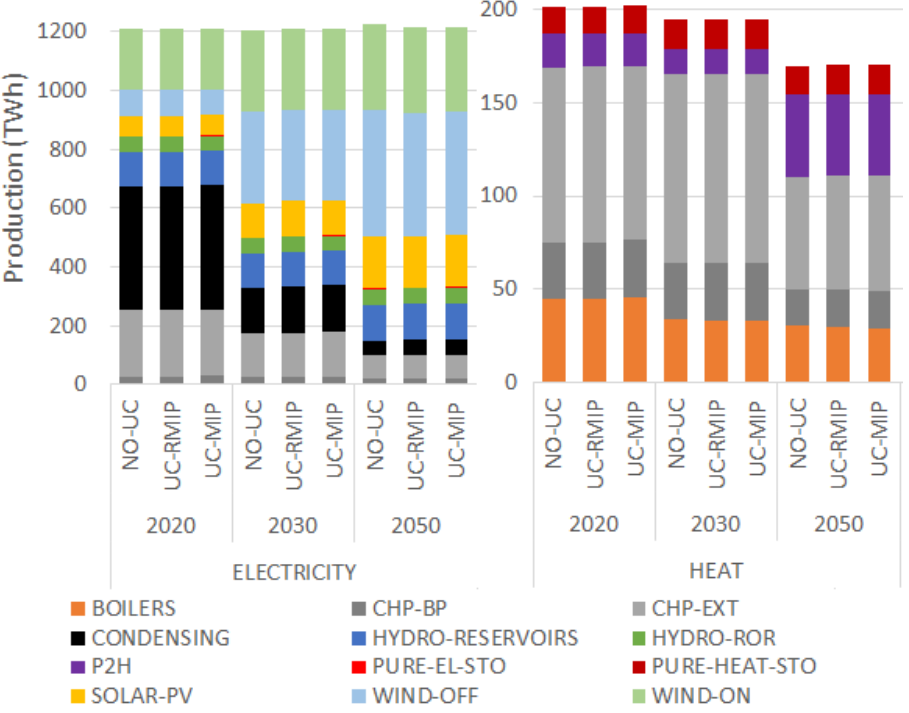
Figure 5. Production development per commodity, year, technology type, and unit commitment (UC) approach